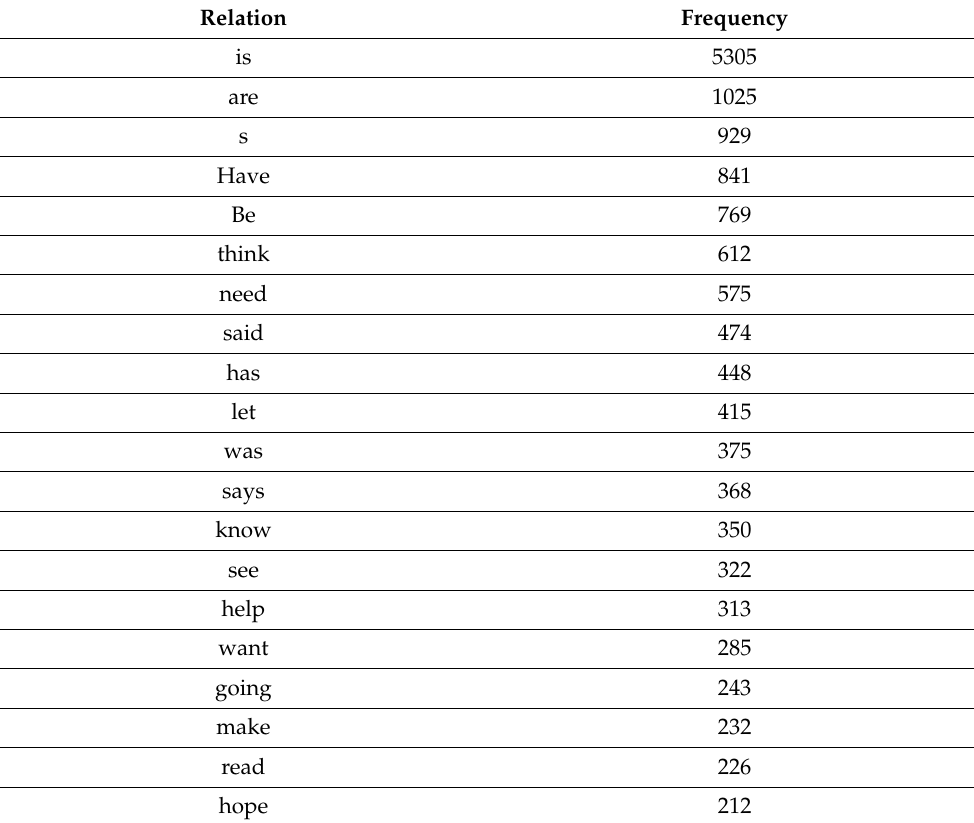
Table 4. Frequency of Relations